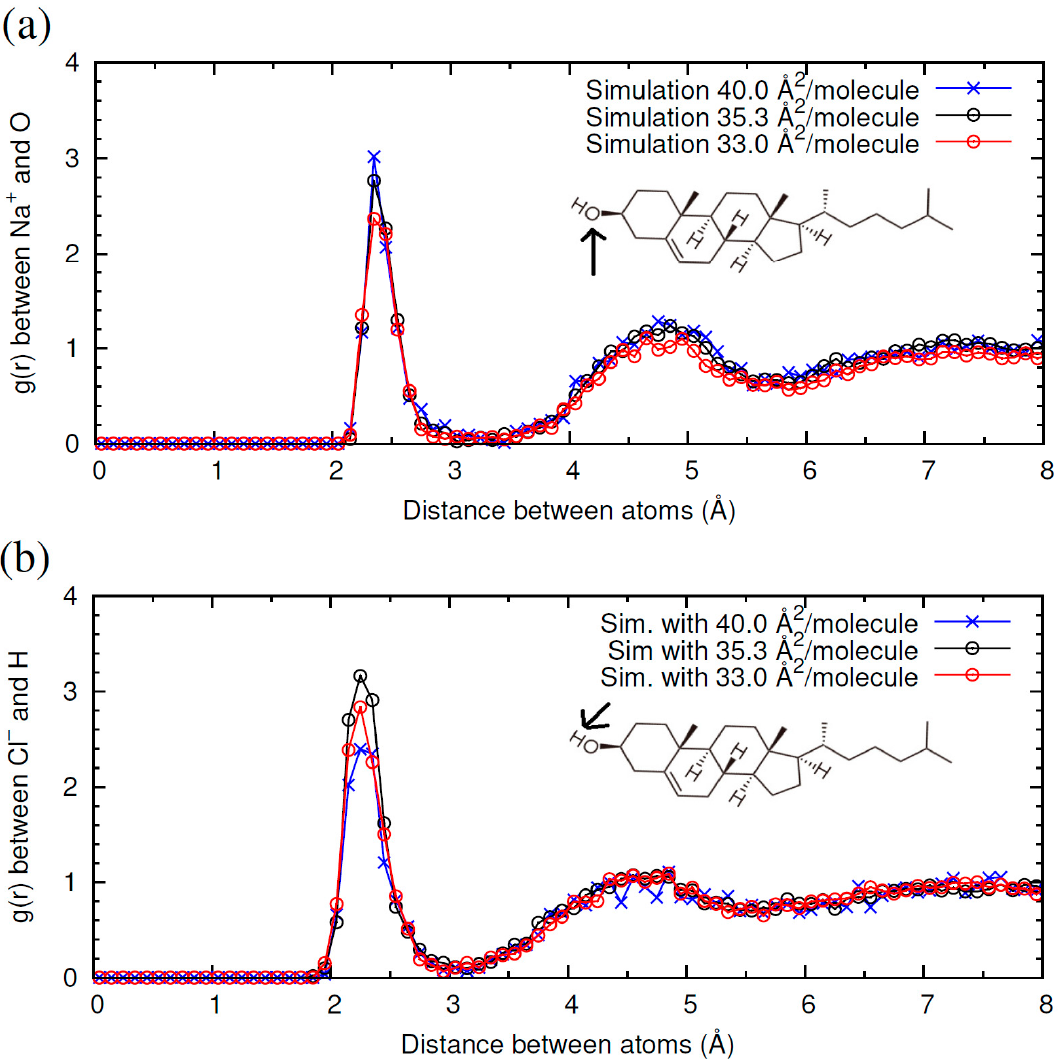
Figure 3. Radial distribution functions g ( r ) between NaCl electrolyte and CHOL headgroup obtained in three different MD simulations with different surface areas of CHOL monolayers: 33.1 Å 2 /molecule (red open circles); 35.3 Å 2 /molecule (black open circles) and; 40 Å 2 /molecule (blue crosses) ( T = 298 K). ( a ) g ( r ) between Na + of NaCl and oxygen atom in -OH headgroup of CHOL; ( b ) g ( r ) between Cl − of NaCl and H atom in -OH headgroup of CHOL. The insets shows the molecular structure of CHOL as a reference. The relevant atom of the headgroup (H or O) is indicated with an arrow.